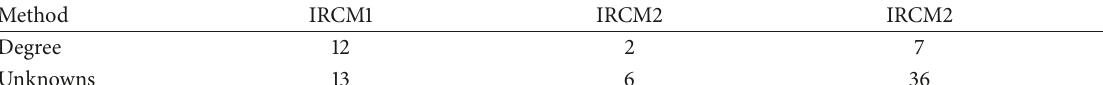
Table 4: Number of coefficients to compute for IRCM1-IRCM2 and PC at different degrees.